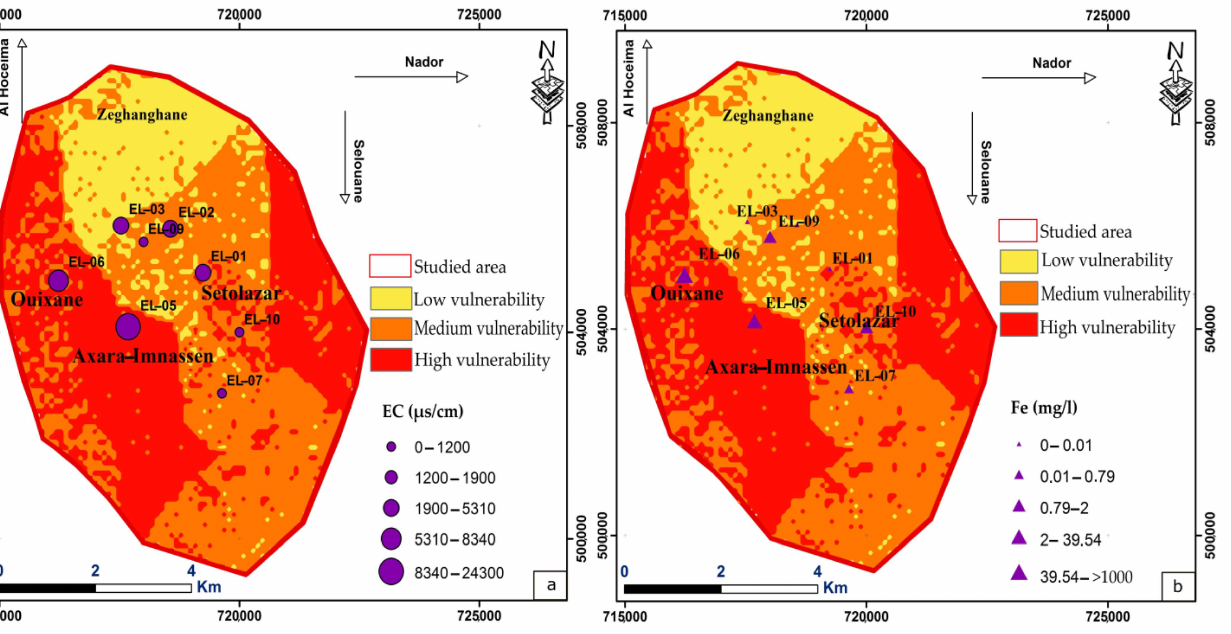
Figure 13. Spatial distribution of groundwater electrical conductivity values (EC) ( a ) and Fe concen- trations (mg/L) ( b ), overlaying groundwater vulnerability map of the iron mining district of